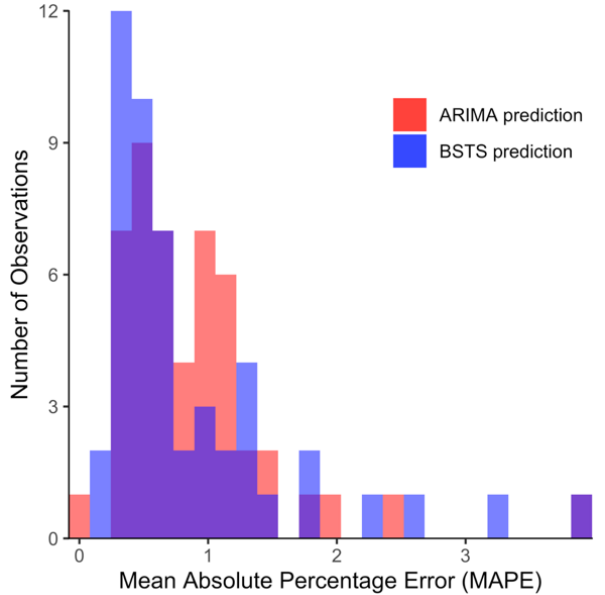
Figure 3. Histogram of the mean absolute percentage error (MAPE) for the BSTS and ARIMA models for each of the 49 apartment units when modeled independently. The ARIMA (red) and BSTS (blue) and overlapping (purple) indicate the difference between the MAPE for the two